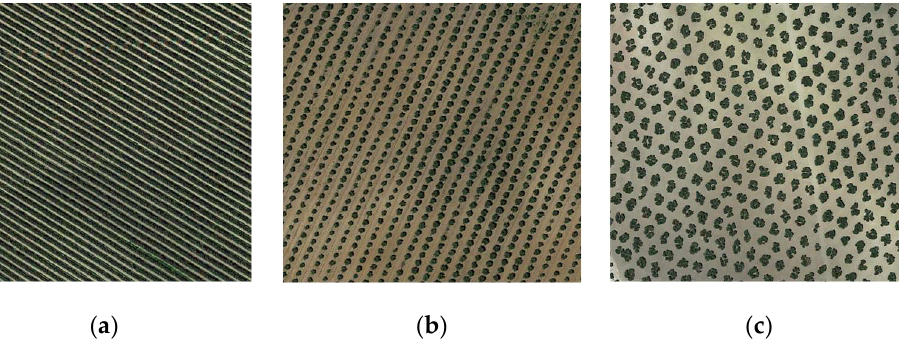
Figure 2. Detail of the olive grove management systems: ( a ) Super-intensive; ( b ) Intensive, and ( c ) Traditional.